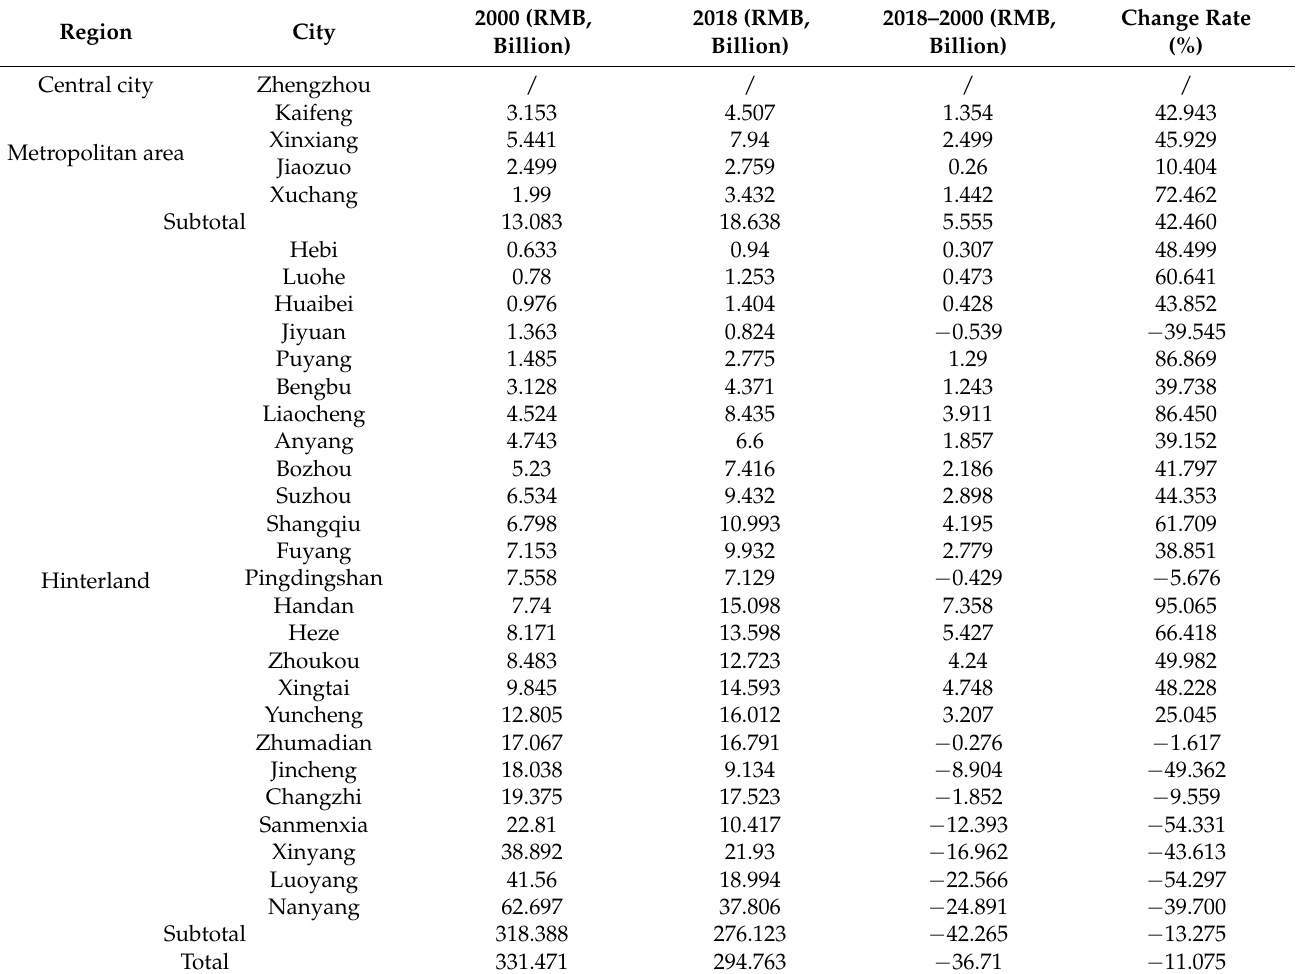
Table 6. ESV spatial transfer amount and its changes in the Central Plains Urban Agglomeration from 2000 to 2018. Region